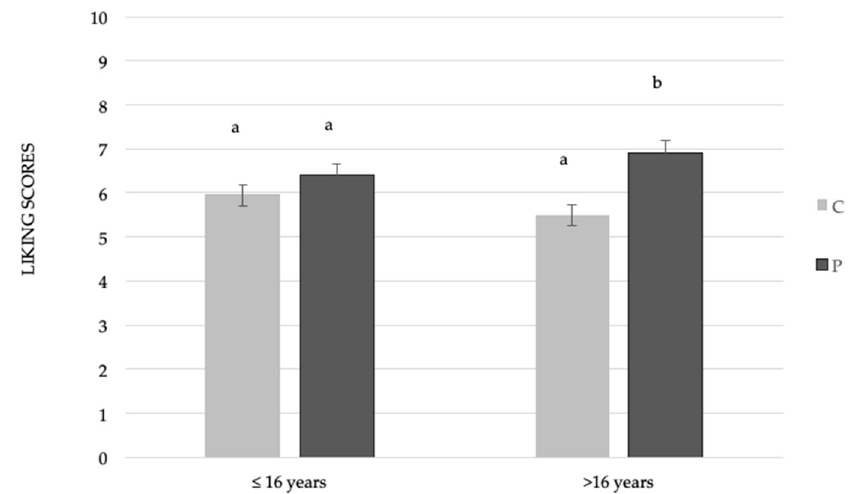
Figure 1. Mean liking scores ± SEM by samples according to age. Different letters indicate significant differences according to a post-hoc test for each sample.